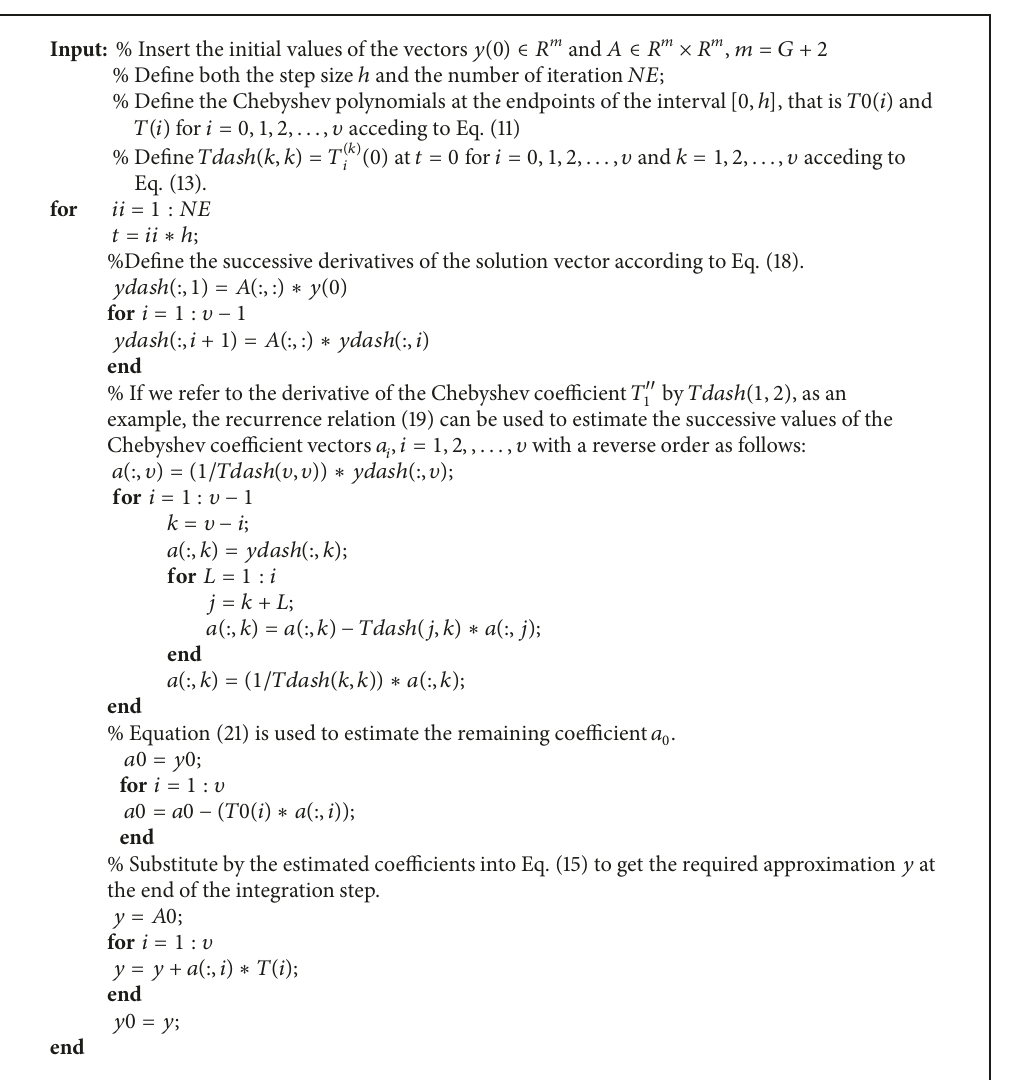
Algorithm 1: The Chebyshev series method of order 𝜐 with constant matrix 𝐴